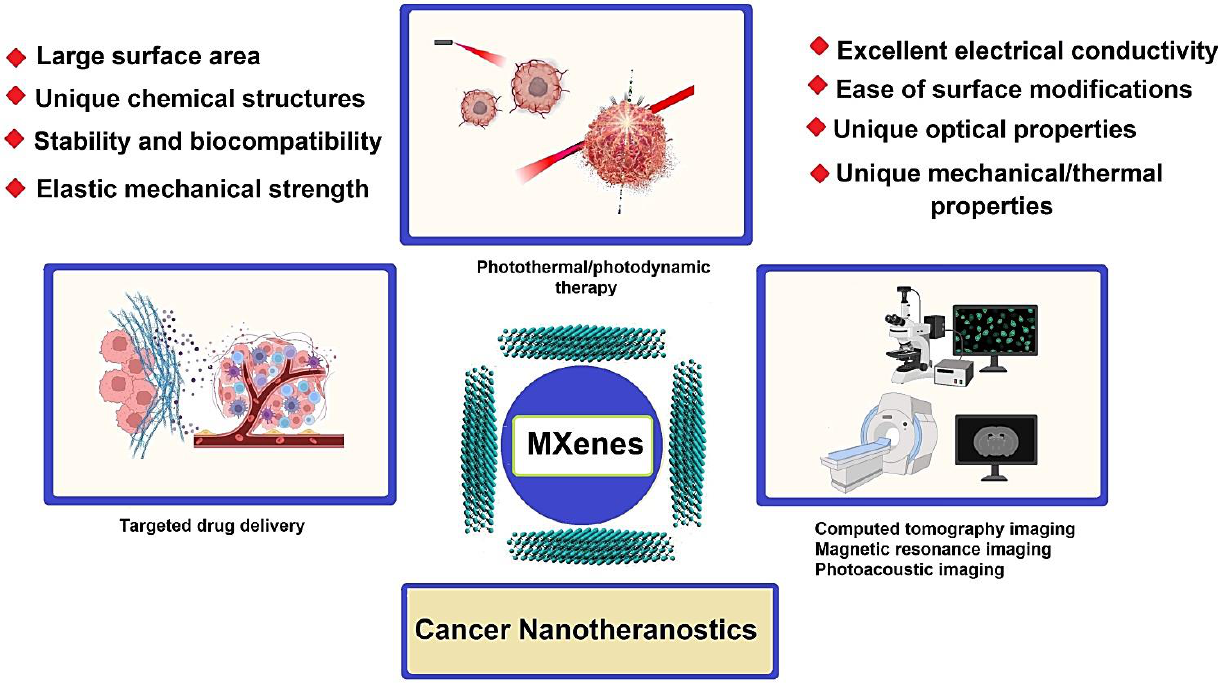
Figure 1. MXenes with cancer nanotheranostic applications. Table 1. Some selected examples of MXenes for cancer nanotheranostics.